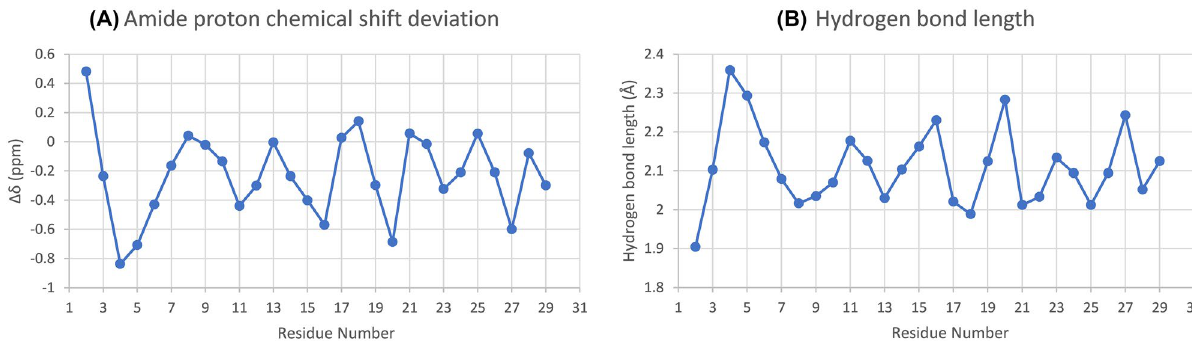
Figure 3. ( A ) Amide proton chemical shift deviation plot of palustrin-Ca in 50% TFE- d 3 -H 2 O. The observed amide proton chemical shifts were compared to the standard random coil chemical shifts ( �δ = δ obs − δ rc ). ( B ) Hydrogen bond distance as calculated from the chemical shift deviations ( �δ = 19.2 d denotes hydrogen bond length 72 .